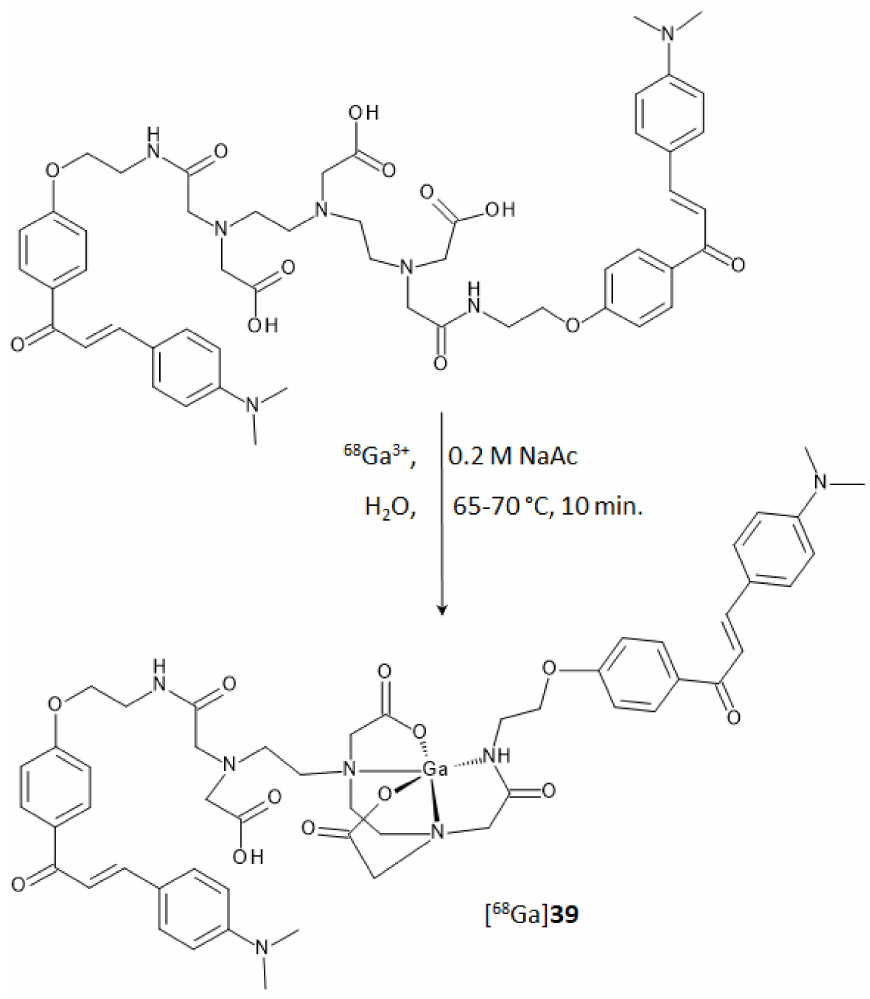
Figure 15. Synthesis of homodimer [ 68 Ga]DTPA-chalcone derivative (compound [ 68 Ga] 39 ). Binding studies of [ 68 Ga]- 39 were performed on artificially aggregated A β 42 -peptides and transformation of the saturation binding to a Scatchard plot resulted in a